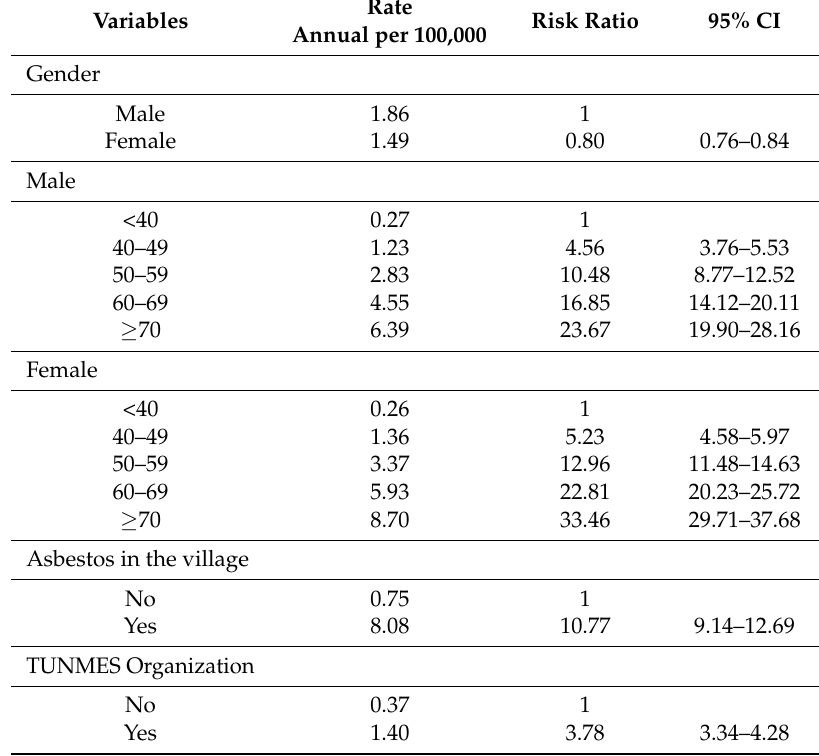
Table 3. Malignant mesothelioma mortality rate and Risk Ratio (95% CI) by gender, age groups, presence of asbestos in the village, and